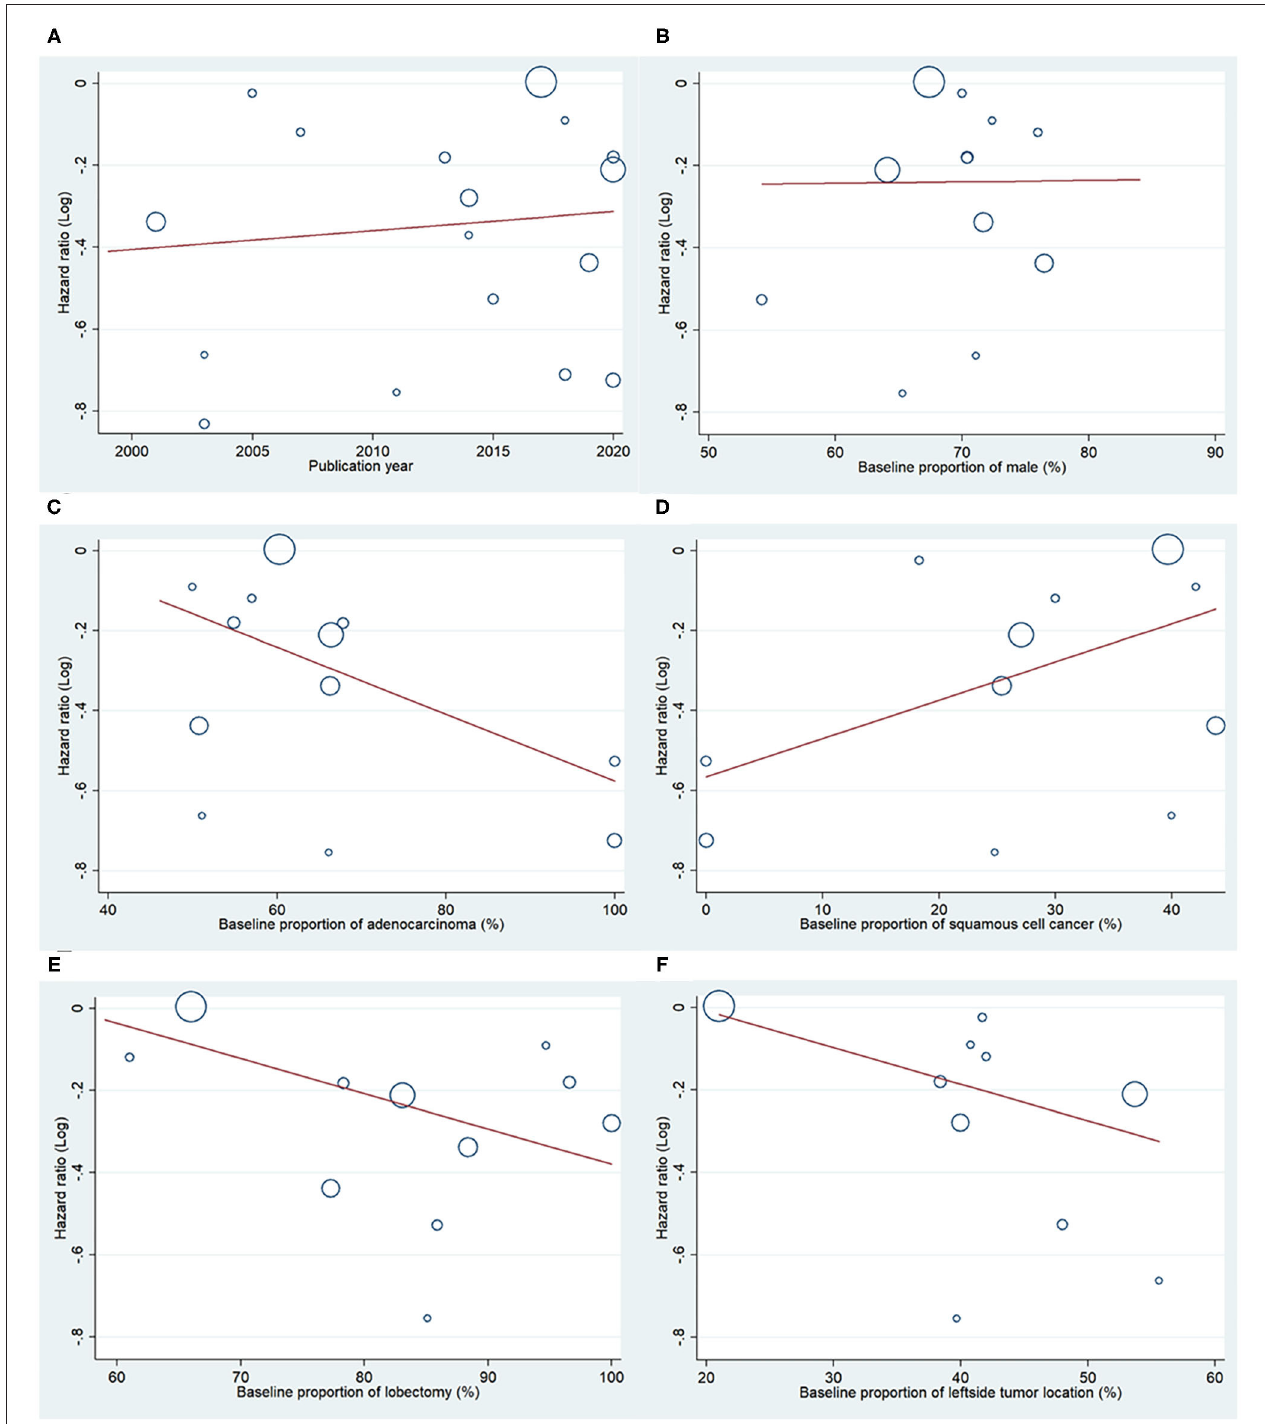
FIGURE 5 | Meta regression analysis for OS. Bubble plot with fitted meta regression line of the log HR for (A) publication year, (B) baseline proportion of male, (C) baseline proportion of adenocarcinoma, (D) baseline proportion of squamous cell cancer, and (E) baseline proportion of lobectomy, (F) baseline proportion of the left side tumor